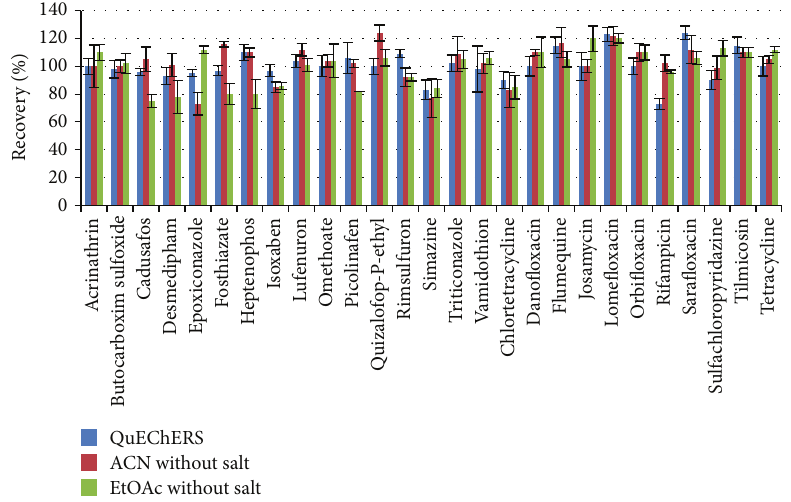
Figure 1: Recovery data for three different extraction